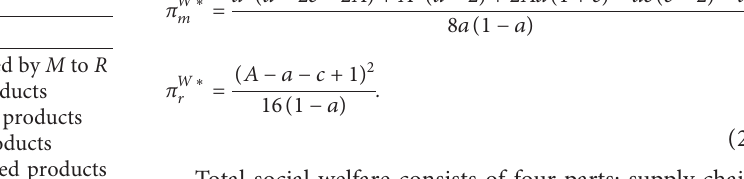
Figure 1: Operational structure diagram of a dual-channel CLSC under government policy. Table 1: Symbols and